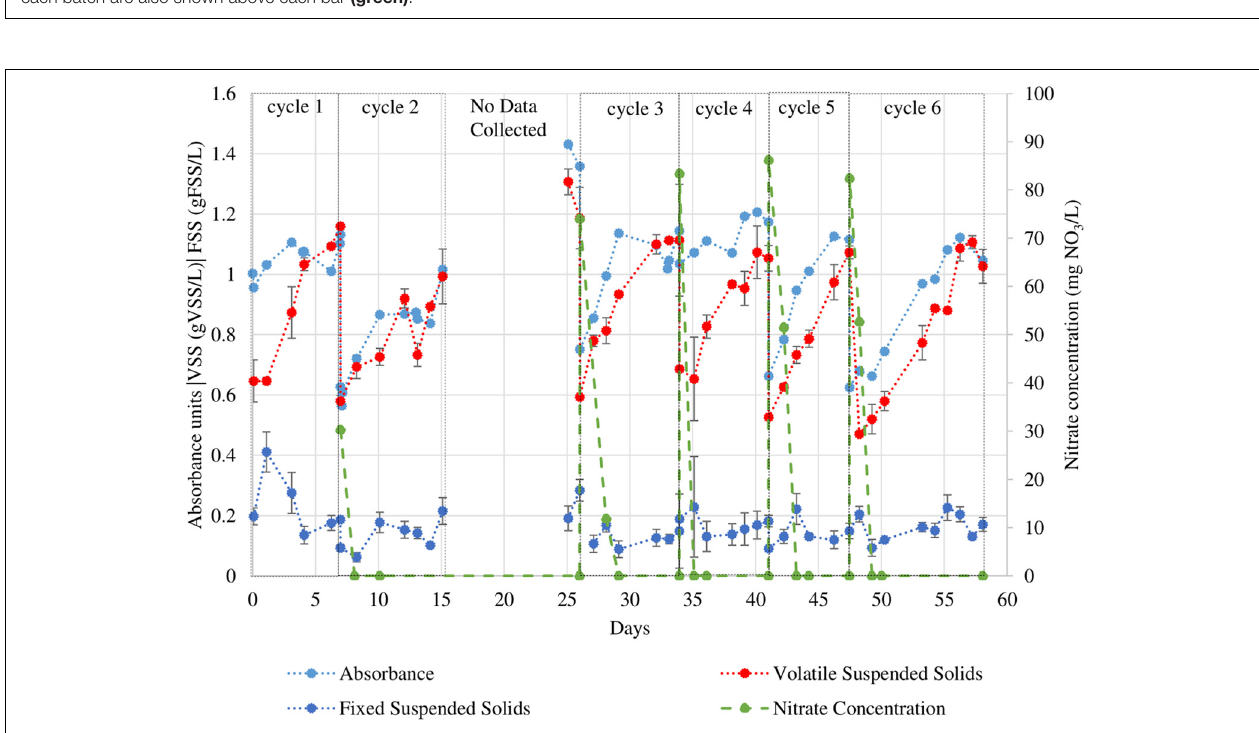
FIGURE 3 | VSS, FSS, and OD 550 readings of T. chuii culture under eight 12h/12h light/dark sequential batch cycles. During the period when data collection was not possible the PBR operation was maintained. Error bars indicate the 95% confidence interval of the solids analyses measurements (obtained from triplicate readings).